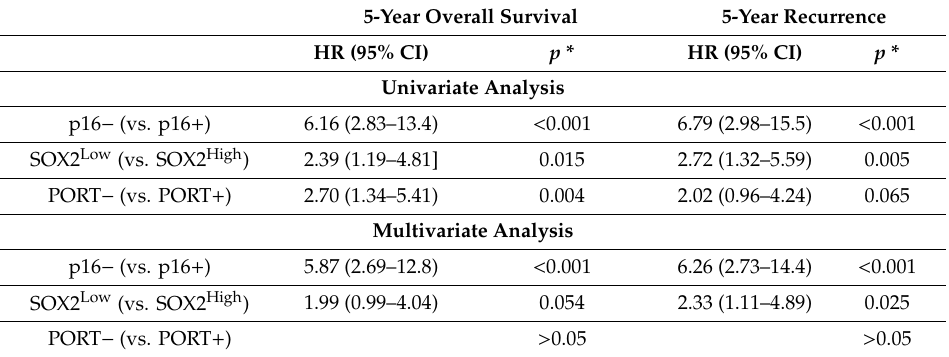
Table 3. Risk factor analysis for 5-year overall survival and recurrence in tumor microarray cohort.